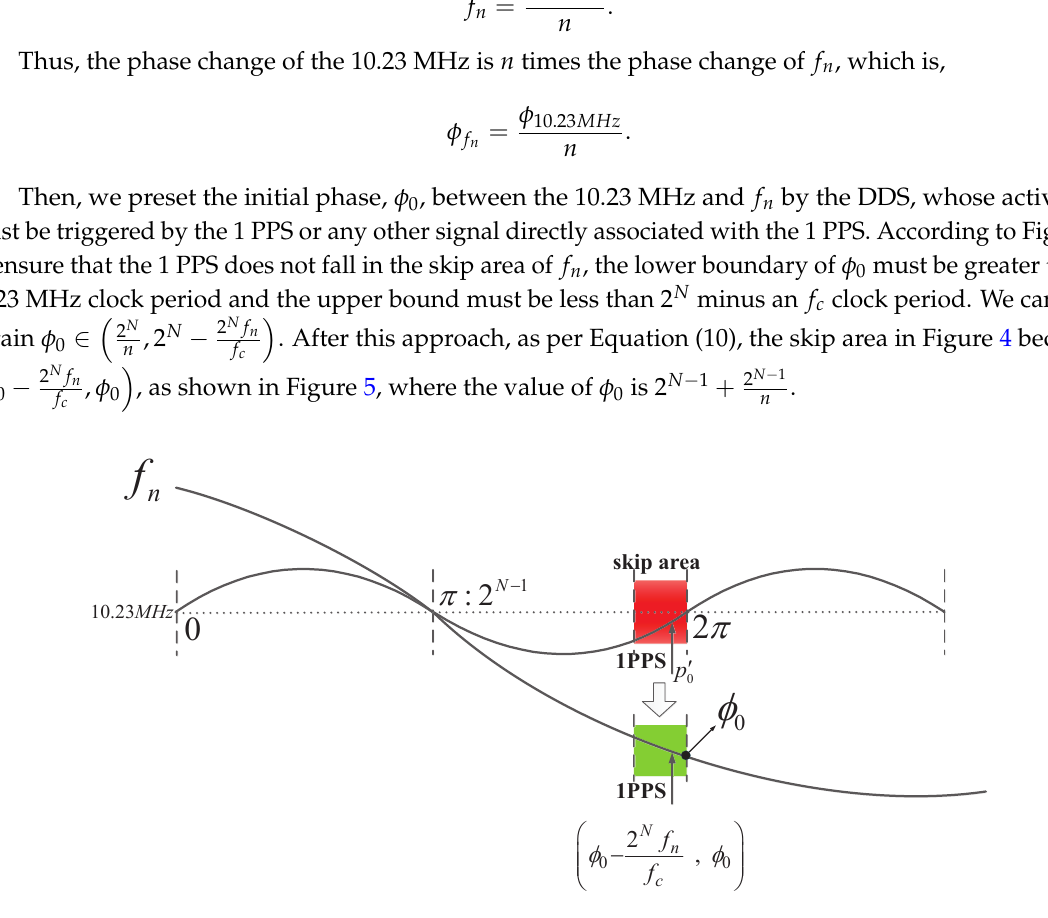
Figure 5. Transferring the skip area of the 10.23 MHz by f n